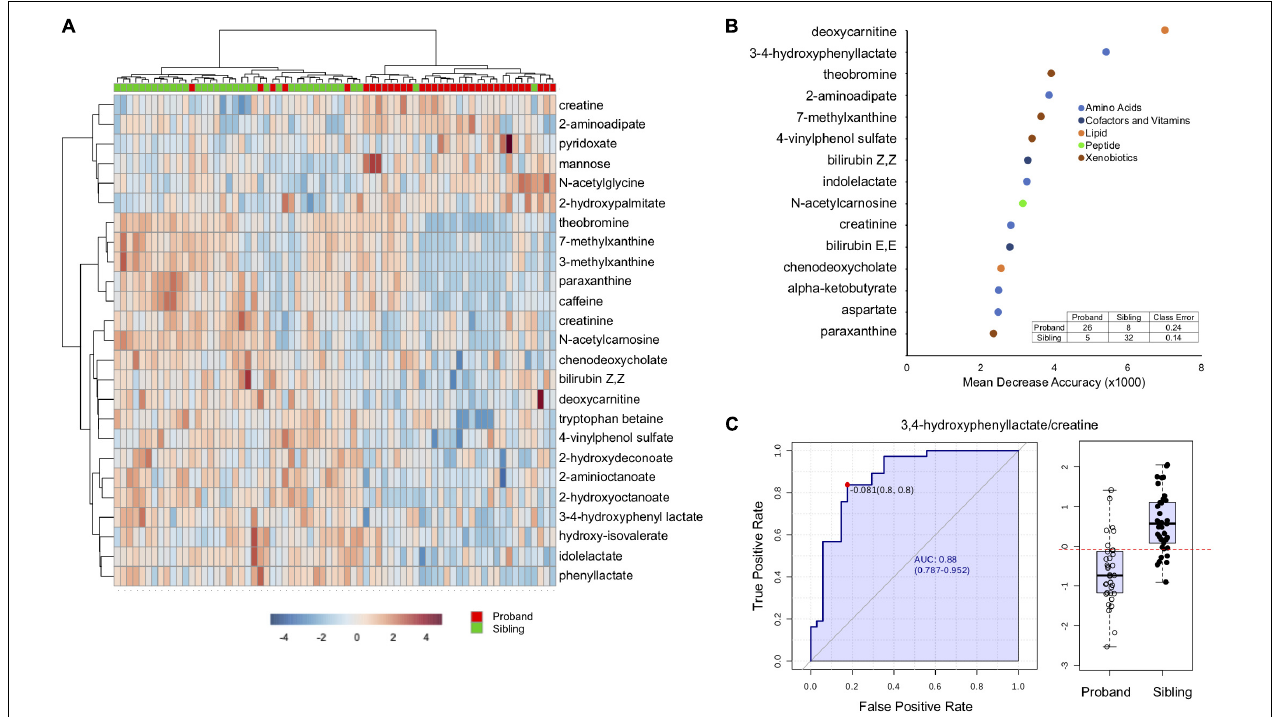
FIGURE 2 | Discriminating features between affected and unaffected individuals. (A) Hierarchical clustering of the top 25 significantly different metabolites. (B) Top 15 metabolites distinguishing affected from unaffected as determined by Random Forest Analysis. The x -axis is the mean decrease accuracy for the metabolite (value × 1000). Metabolite groupings are indicated by colors identified in the legend. The inset shows the out of box based confusion matrix for the random forest classification. (C) The left side of the figure demonstrates the ROC curve for 3,4-hydroxyphenyl acetate/creatine to distinguish affected from unaffected, with the sensitivity on the y -axis and the specificity on the x -axis. The right panel is a box-plot of the metabolite ratio for the two groups, with the boxed values indicating quartiles, and the red dotted line indicating the optimal cutoff for